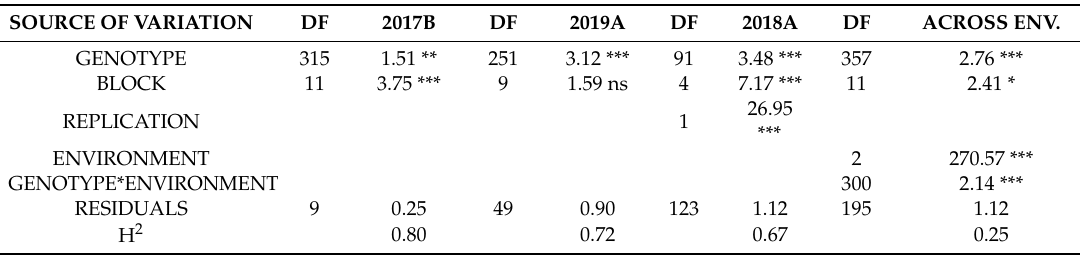
Table 1. Analysis of variance for maize resistance to fall armyworm (FAW) damage in Kasese